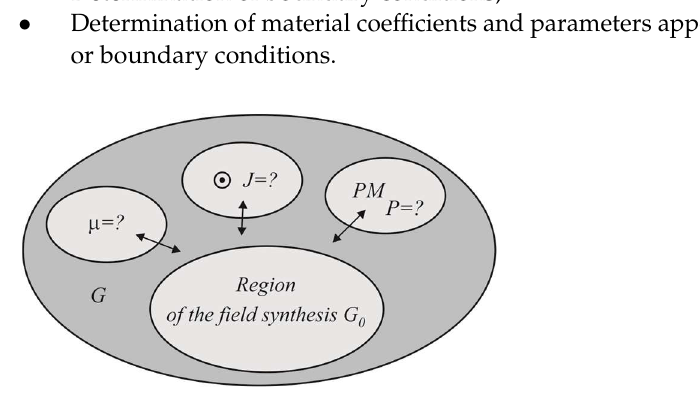
Figure 4. General task of the field synthesis ( J —current density, P —magnetic polarization, μ — permeability).